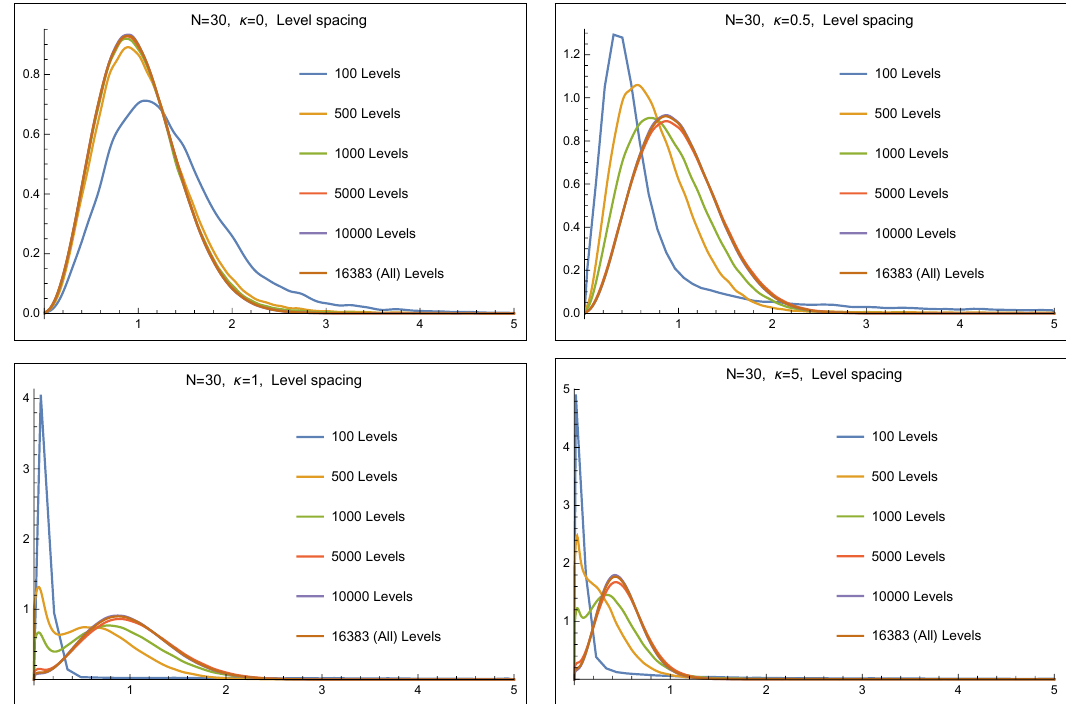
Figure 7 . The level spacing distribution, averaged over M = 312 realizations for the N = 30 Hamiltonian with (cid:20) = 0 ; 0 : 5 ; 5. The distributions are computed on subsectors of the spectra including L levels starting from the ground